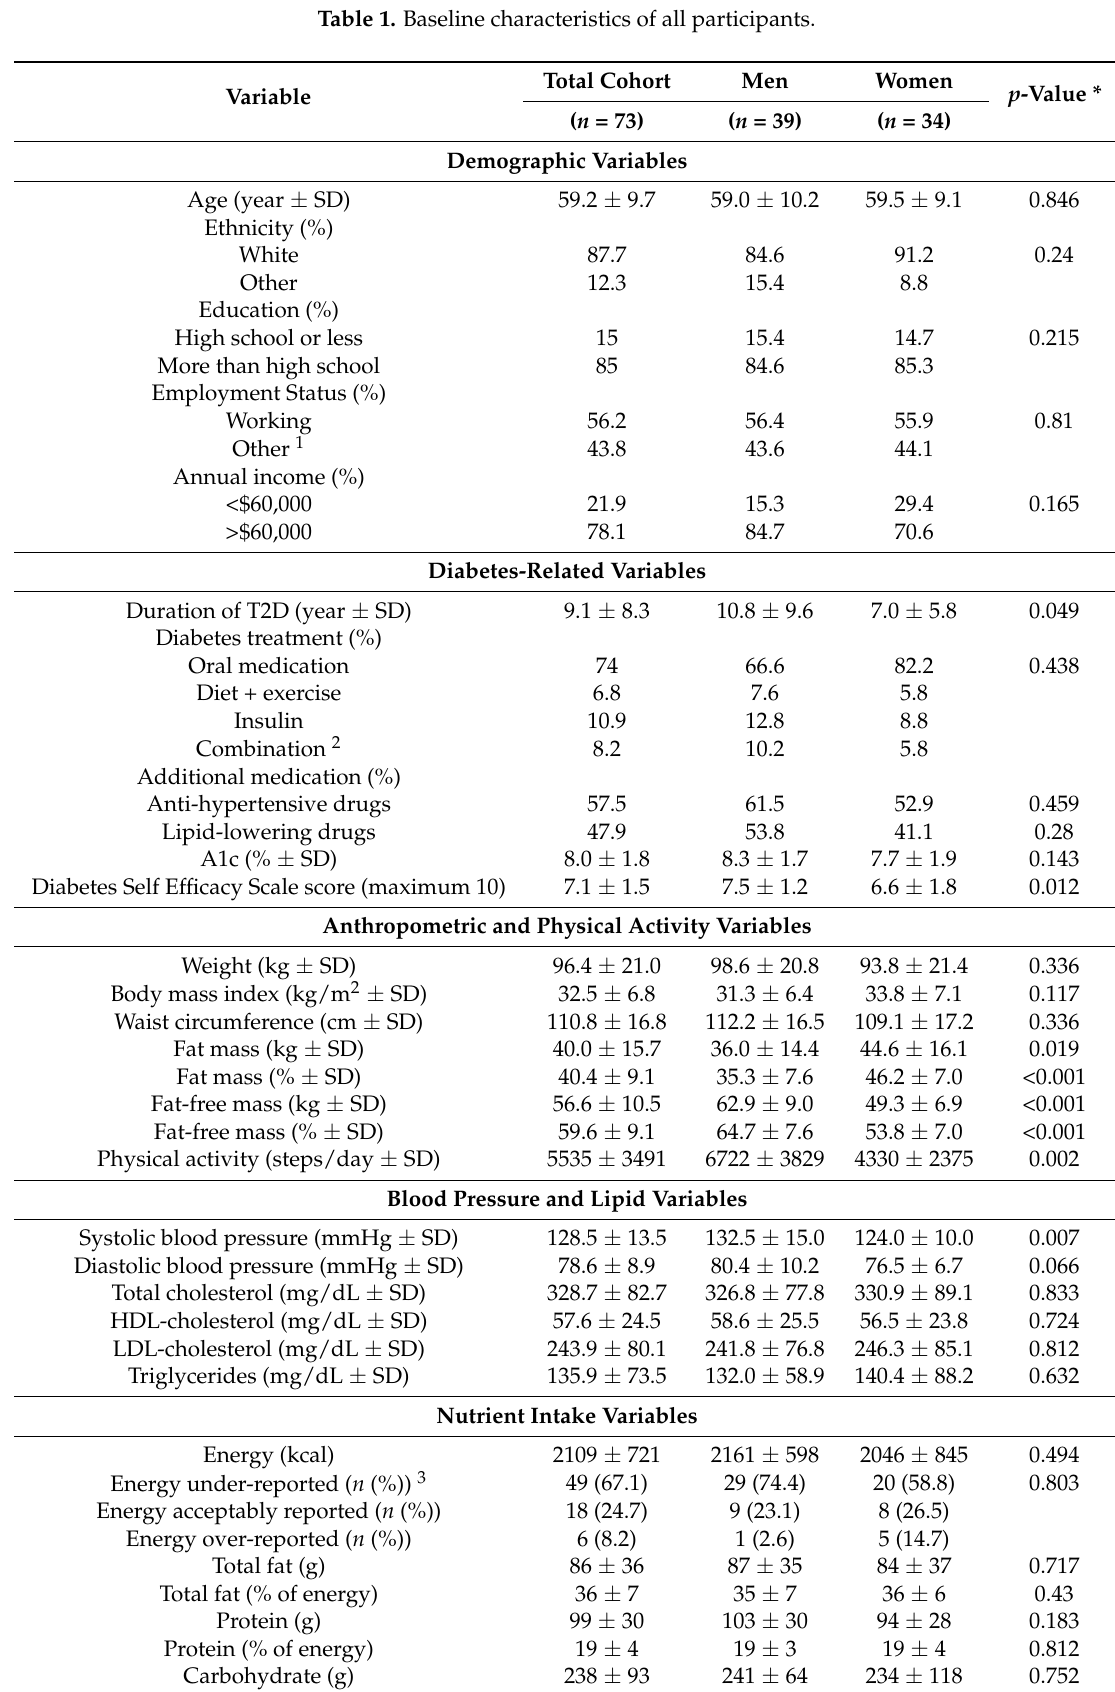
Table 1. Baseline characteristics of all